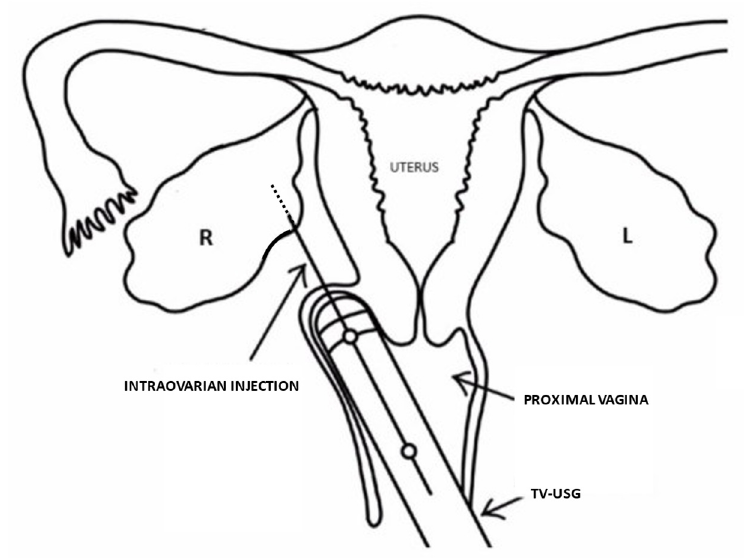
Figure 1. Injection of autologous PRP and/or condensed platelet-derived cytokines via transvaginal ultrasound guidance (TV-USG). Meaningful improvement after this ‘ovarian rejuvenation’ is contingent on in vitro platelet activation and release of soluble mediators to augment angiogenesis. These include epidermal growth factor, vascular endothelial growth factor, basic fibroblast growth factor, platelet-derived growth factor, transforming growth factor, platelet-derived angiogenesis factor, as well as several interleukins. After sample placement within ovarian tissue, serum anti-Mullerian hormone (AMH) level is measured over three months to assess potential changes in ovarian reserve. Post-treatment AMH patterns appear directly correlated with baseline platelet concentration [27]. Using standard IVF equipment, bilateral ovary PRP injection may be safely performed in ≤ 20 min without anesthesia or sedation [7].